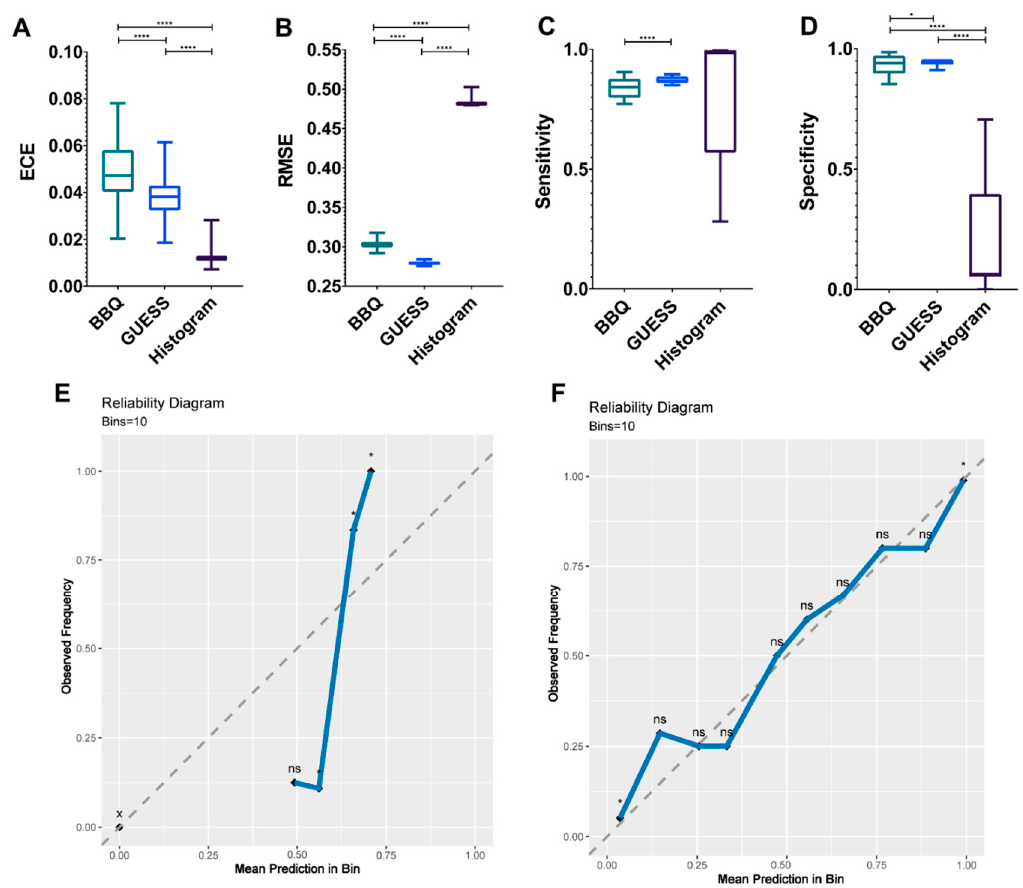
Figure 4. Bar plots to compare the discrimination index, including the expected calibration error (ECE) ( A ) and the root mean square error (RMSE) ( B ) according to three calibration models. Sensitivity ( C ) and specificity ( D ) are compared among the three models. Each plot represents the minimum, maximum, and mean value. Reliability diagram before calibration ( E ) and after calibration using the ‘GUESS’ model ( F ). The “x” axis represents the prediction score and the “y” axis indicates the observed frequency that is the probability of pseudoprogression (PsPD). Ten bins are used as the reliability plot. A binomial test is performed to determine the statistical significance of class distributions. **** p < 0.0001, * p < 0.05. x, empty bin; ns, non-significant. p values ( A – D ) were estimated by a repeated measure one-way analysis of variance test with multiple comparisons. Abbreviations: BBQ, Bayesian Binning in Quantiles.